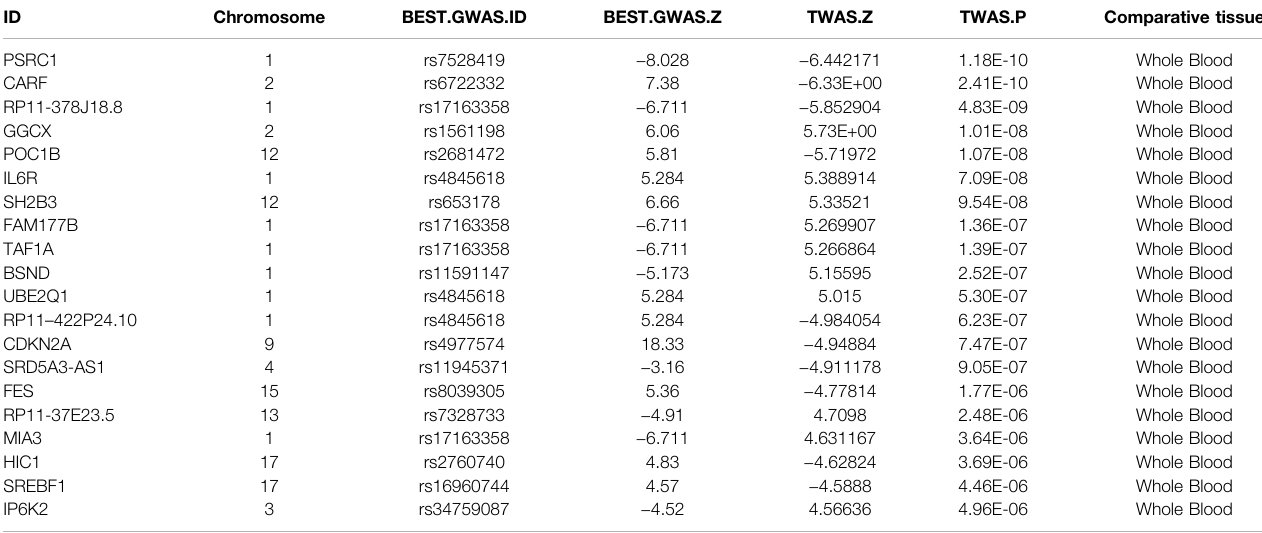
TABLE 1 | The top 20 candidate genes identi fi ed by TWAS for AMI. ID